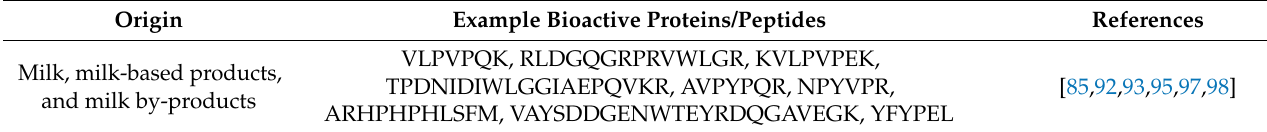
Table 2. Most common animal-based antioxidant proteins and